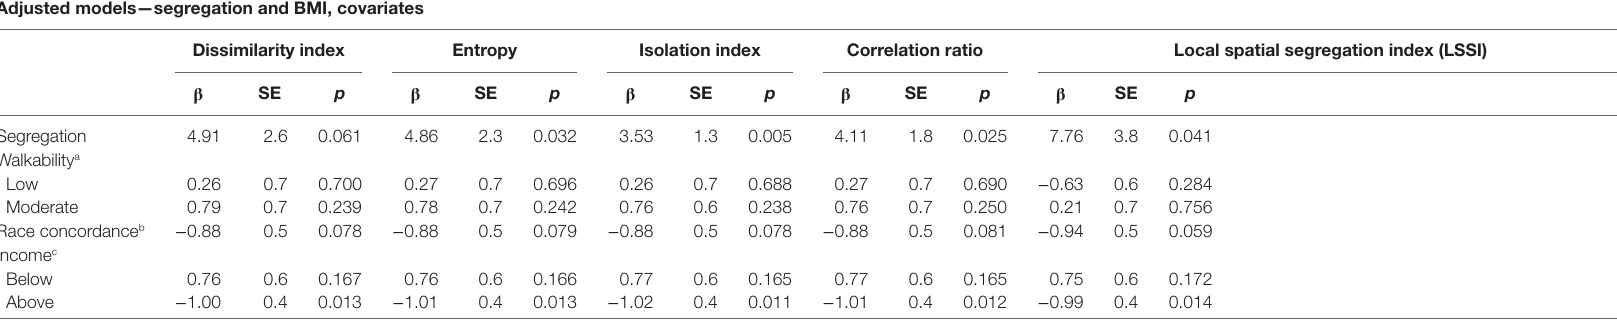
Dissimilarity index and mrFei